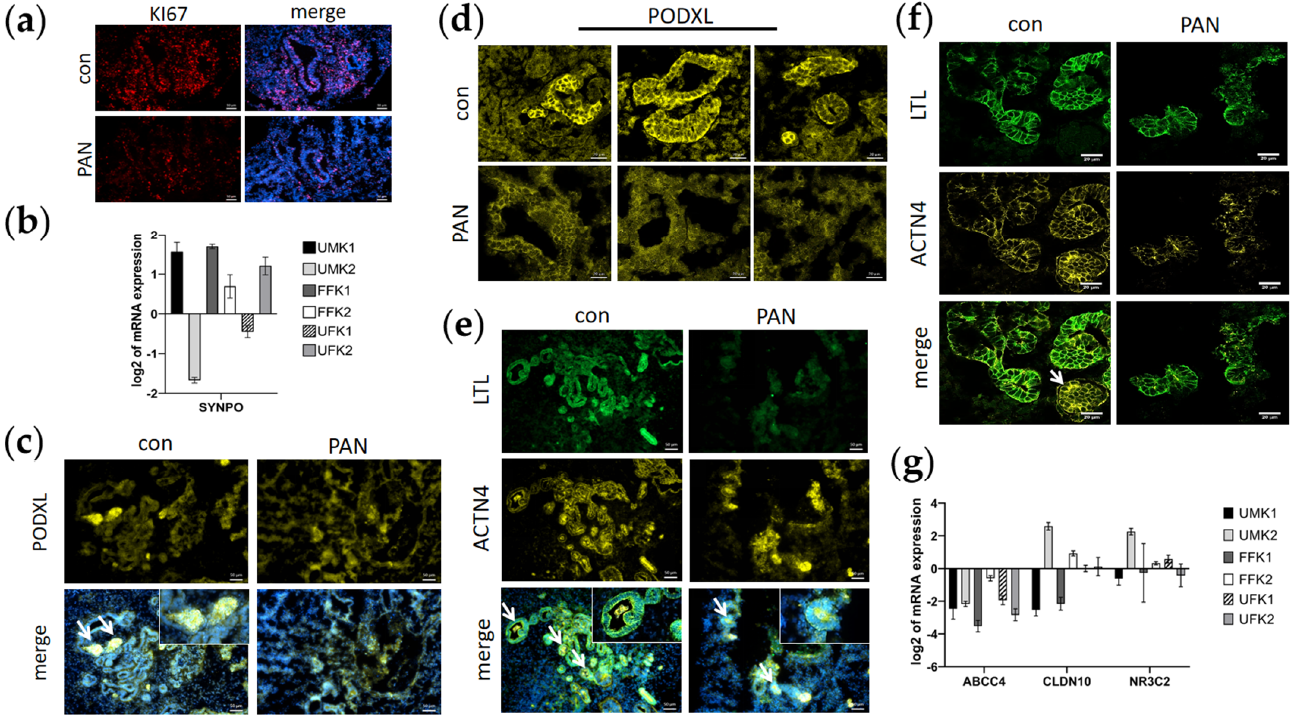
Figure 3. PAN leads to less defined glomerular and tubular structures. ( a ) PAN induction leads to a decrease in the number of highly proliferative KI67+ cells (red). Nuclei were stained with Hoechst33342 (blue). Scale bar depicts 50 µm. ( b ) Expression of the podocyte marker SYNPO is upregulated (UMK1, FFK1, FFK2, UFK2) after PAN treatment. Error bars depict standard error. ( c ) PODXL+ glomeruli (yellow) are less defined after PAN treatment. Glomeruli are marked with a white arrow. Nuclei were stained with Hoechst33342 (blue). Scale bar depicts 50 µm. ( d ) Confocal microscopy pictures of PODXL+ glomeruli with and without PAN. Scale bar depicts 20 µm. ( e ) LTL+ proximal tubules (green) and ACTN4+ glomeruli (yellow) are less defined after PAN treatment. Glomeruli are marked with a white arrow. Nuclei were stained with Hoechst33342 (blue). Scale bar depicts 50 µ m. ( f ) Comparative confocal pictures of ACTN4 (yellow) and LTL-stained (green) organoid sections treated with and without PAN. Scale bar depicts 20 µ m. Glomeruli are marked with a white arrow. ( g ) Expression of the tubular markers ABCC4 , CLDN10 and NR3C2 are downregulated by PAN. Error bars depict standard